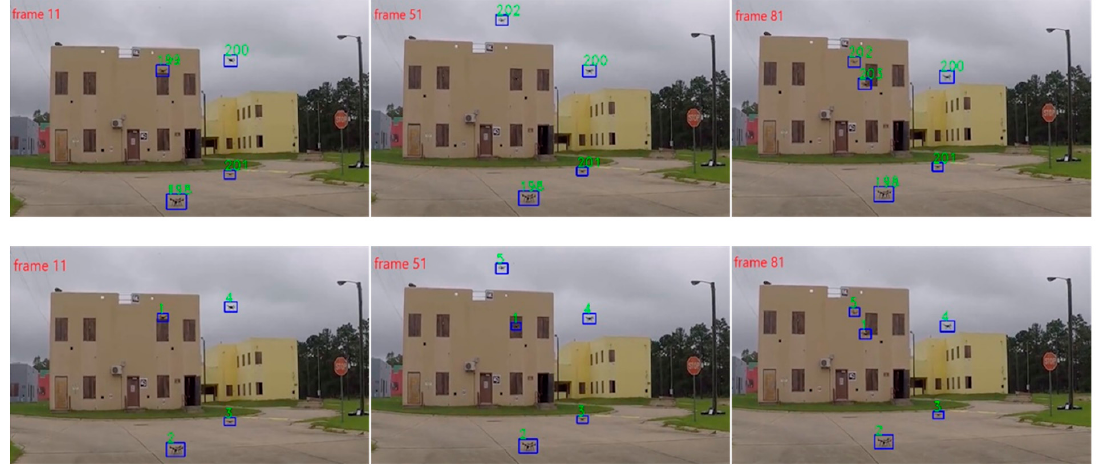
Figure 11. Tracking results of UAVSwarm − 30 (Top: ByteTrack; Bottom: GNMOT; 11th, 51st, and 81st frames, from left to right).